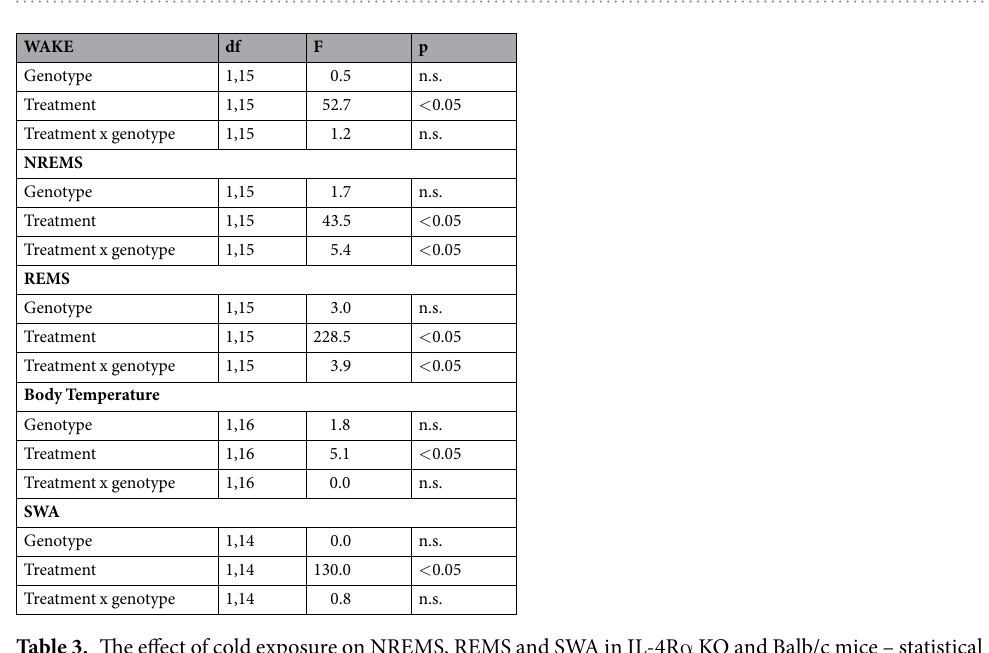
Figure 3. Changes in NREMS, REMS, and EEG SWA in the first 12 hours of 10 °C cold exposure in WT (white bars) and IL-4 R α KO (red bars) mice. Data are calculated in 12-h time blocks, as differences from the baseline at 30 °C. Error bars represent SEM. * Significant difference from baseline (paired t -test, p < 0.05), # significant difference between genotypes (Student’s t -test, P < 0.05).